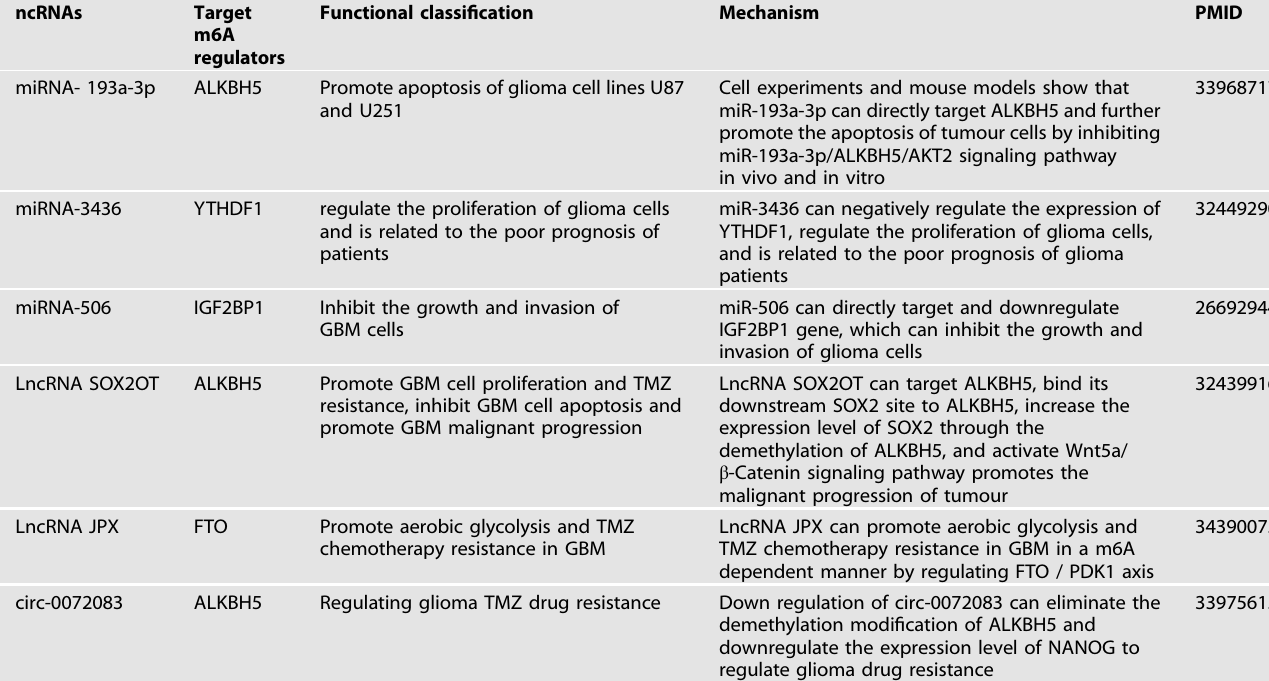
Table 2. Targeted regulation of m6A regulators by ncRNAs in